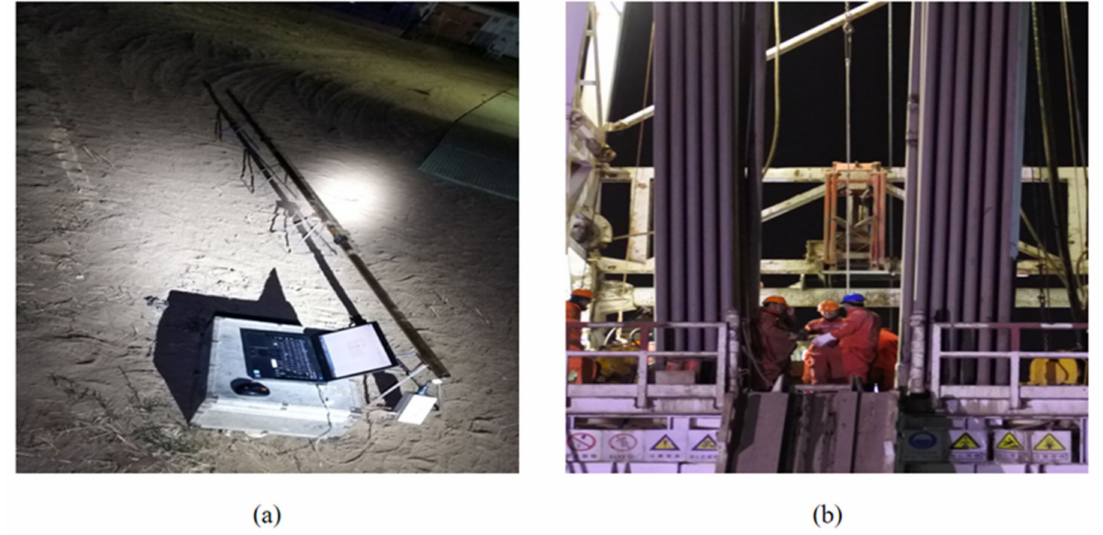
Figure 19. ( a ) Ground north-finding for fiber-optic gyro (FOG) while drilling; ( b ) Go down well with LWD